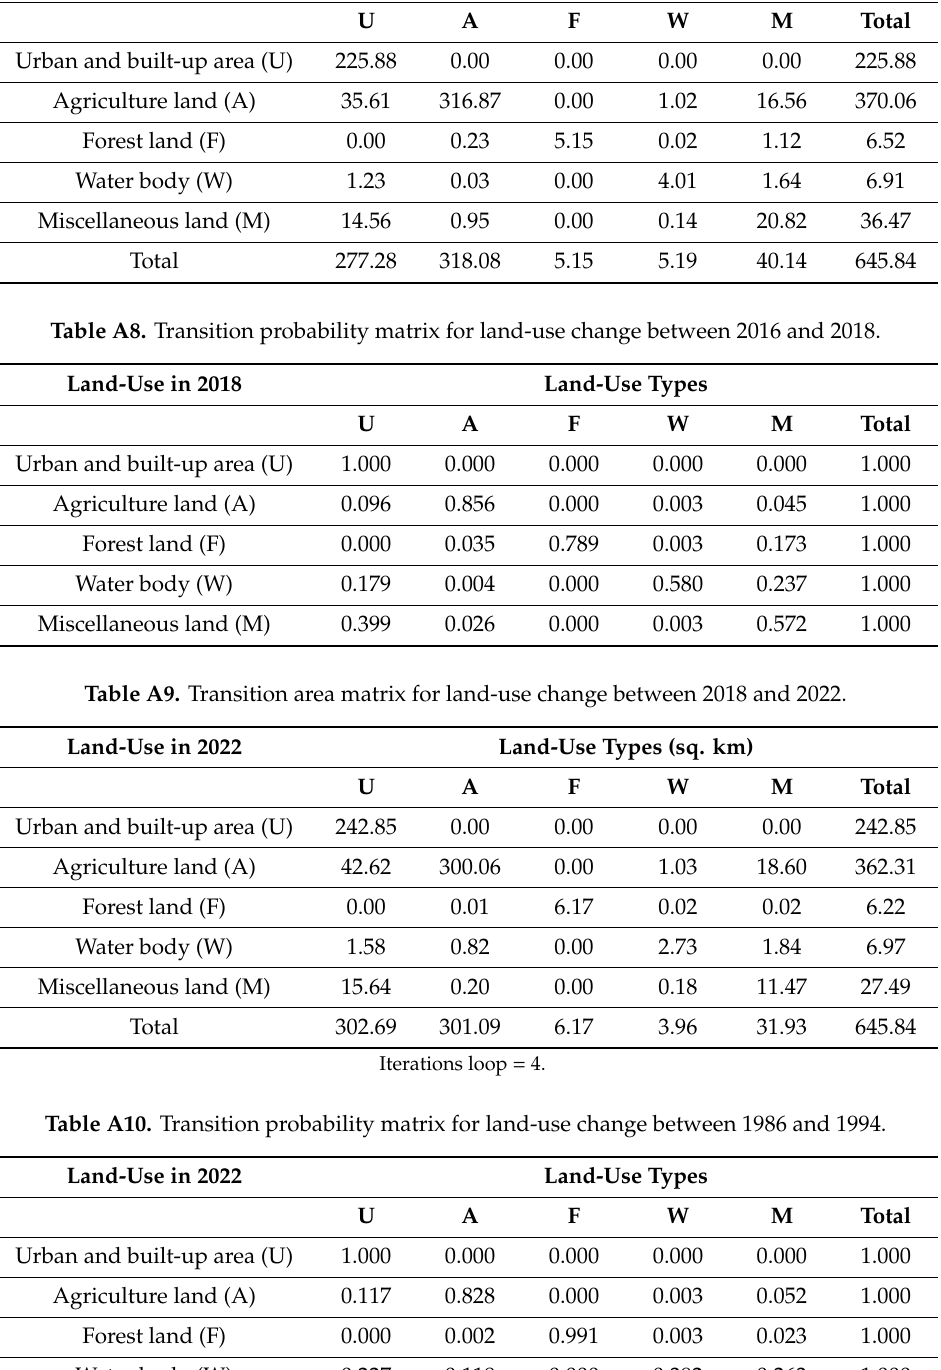
Table A7. Transition area matrix for land-use change between 2016 and 2018. Land-Use in 2018